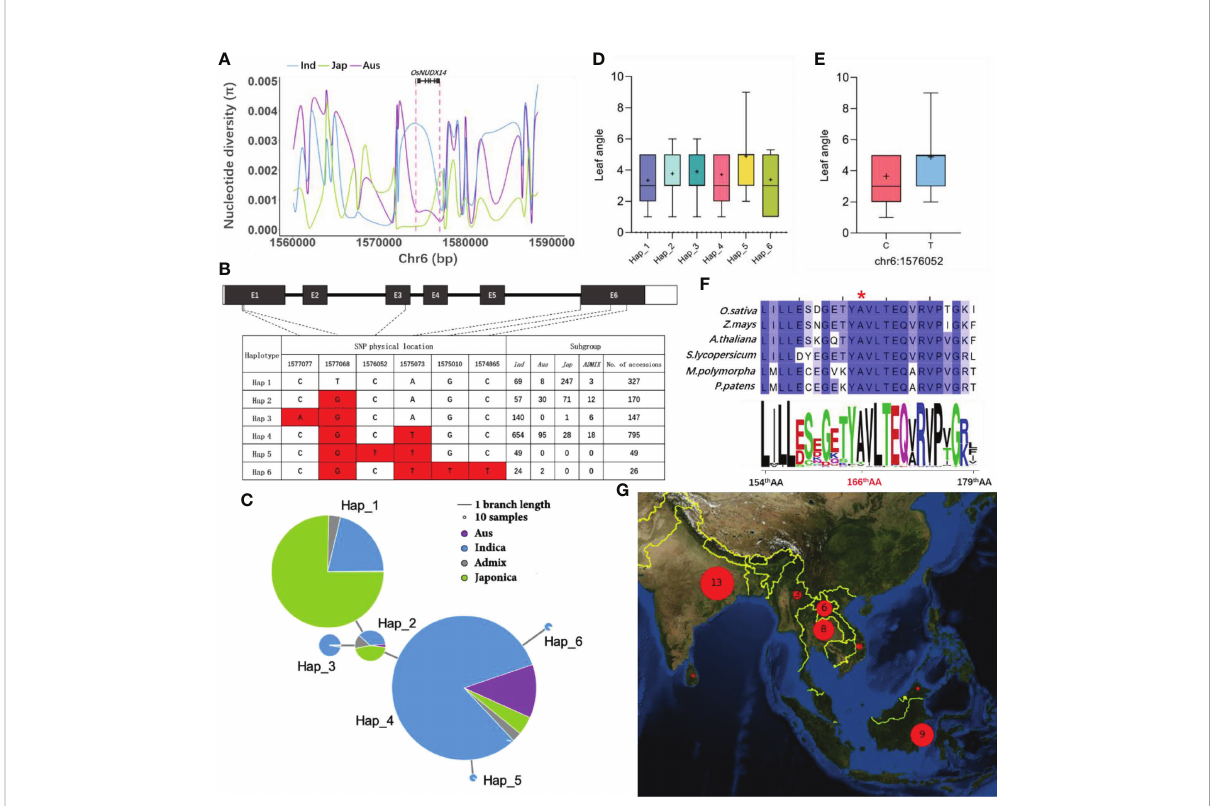
FIGURE 7 Natural variation analysis of OsNUDX14 . (A) Nucleotide diversity analysis of a 30 kb region of OsNUDX14 . Different-colored lines represent different groups; Xian / Indica (blue), Geng / Japonica (green), and Aus (purple) respectively. (B) Haplotype analysis of OsNUDX14. Hap_1 is the reference allele, and the red box indicates a variation as compared to Hap_1. (C) The haplotype network of OsNUDX14 . The length of the branch line correlates to haplotype similarity and the size of the circle is proportional to the number of accessions. Different groups of germplasm are represented by different colors. (D) Leaf angle analysis in different haplotypes. The box diagram shows leaf angles with values between 10% and 90%, and the plus sign “ + ” indicates the mean value. (E) A unique missense mutation, 1576052C/T in Hap_5 displayed a larger leaf angle. (F) Conservation analysis of OsNUDX14 ’ s 165 th AA. Multiple sequence alignment of OsNUDX14 from six different plant species and their corresponding sequence logos were calculated using 54 orthologs. The red asterisk indicates the missense amino acid variation caused by 1576052C/T. (G) Geographic distribution analysis of 1576052C/T. Geographic distribution of chr6:1576052-T cultivars. Red circles represent varieties and all of them are distributed in Southeast Asia and South